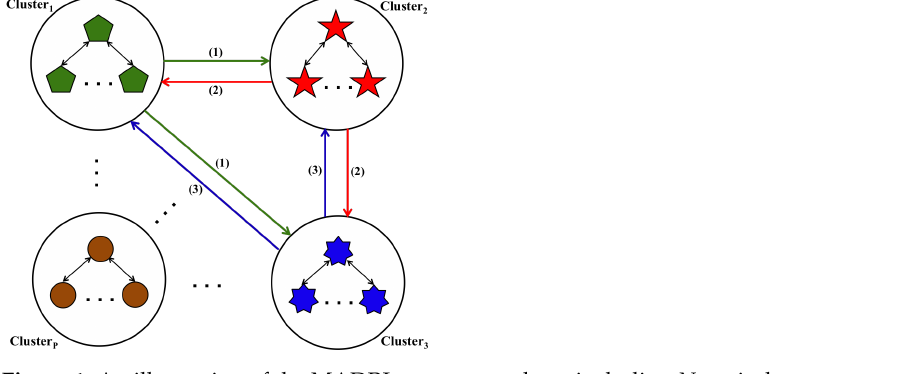
Figure 1. An illustration of the MADRL system topology, including N static, heterogeneous agents, and P